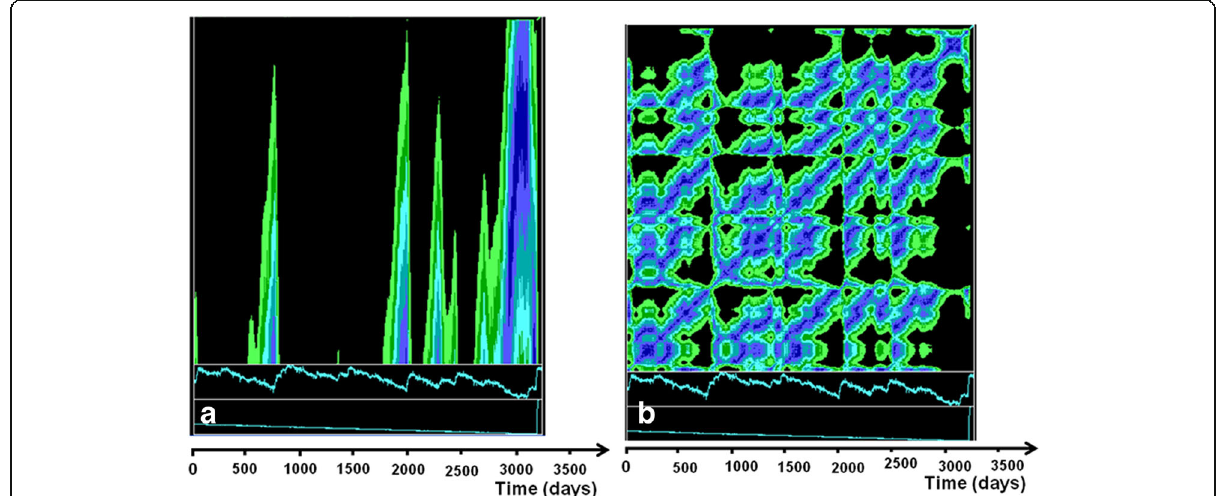
Fig. 23 Cross recurrence plot ( a ) and joint recurrence plot ( b ) for the raw CNST_e signal and the KAIK_e signal with the linear trend included. These plots are to be compared with Fig. 21e,